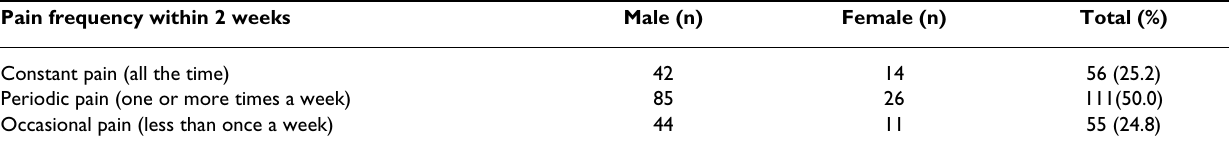
Table 2: Health indicators of study participants (Continued)